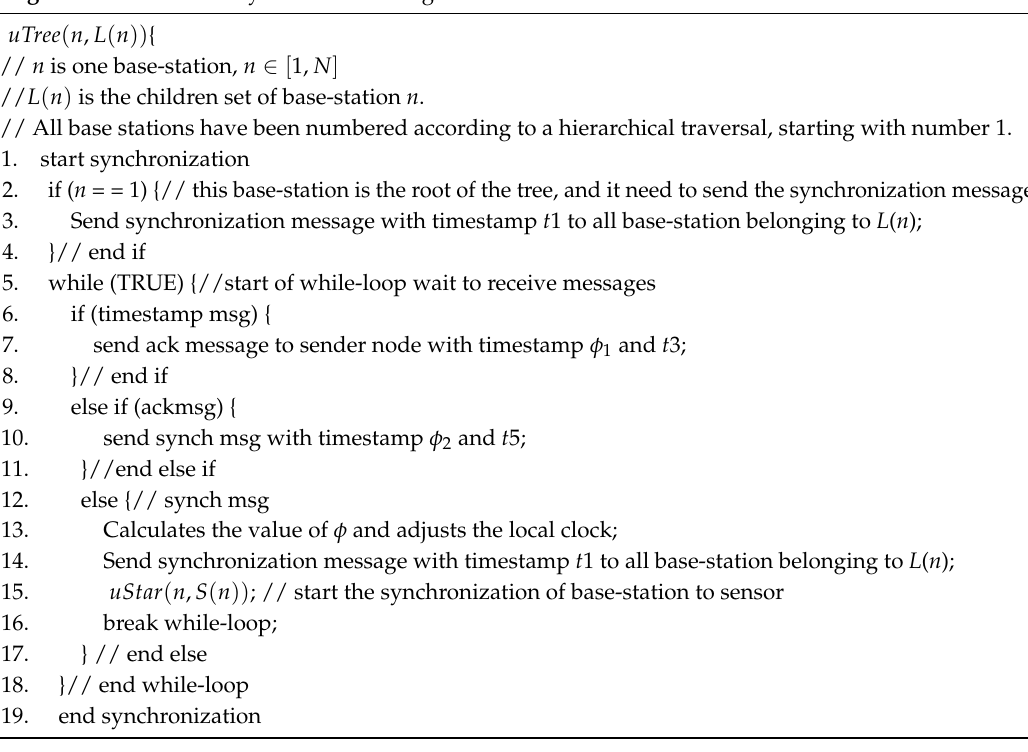
Algorithm 1. The clock synchronization algorithm for base-station to base-station. uTree ( n , L ( n )) { // n is one base-station, n ∈ [ 1, N ] // L ( n ) is the children set of base-station n .